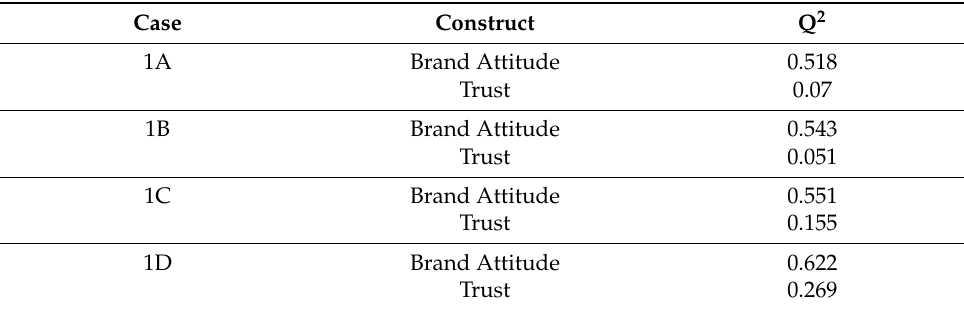
Table A8. Predictive Relevance of each case in Delivery Service Scenario.